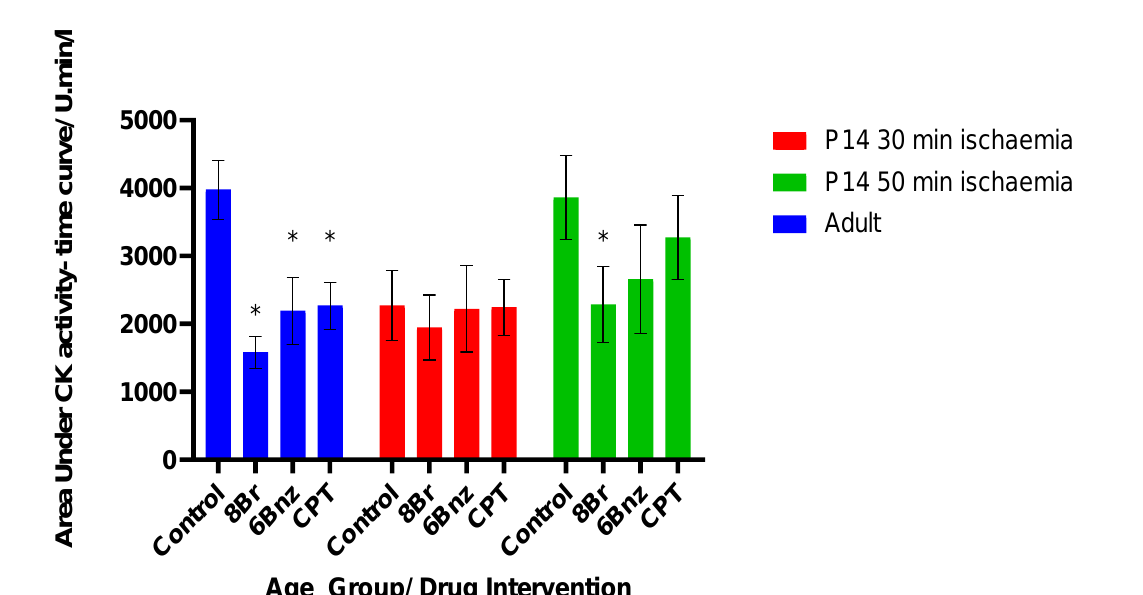
Figure 3. Total activity for CK in each age and treatment group for the cAMP analogue experiments. Total activity taken as estimated area under activity–time curves summed by trapezoidal addition of mean values for each time point. Bars represent mean area under curve of activity/time curves ± SE; * = p < 0.05 vs. same age group control. Significance tested by Student’s t -test. n = 6 per group. Hearts from 14-day-old rats (P14) were exposed to 30 or 50 min of global ischaemia (Figures 2B and 2C, respectively). The immature hearts exposed to 30 min of ischaemia did the time points studied. The peak activity level in the control was reduced to 58.6% of that seen in the adult control group, and arrived in a later fraction. Similarly, the area under the activity time curve in the P14 30 min ischaemia group was 57.1% of that in the adult group, representing a lower overall degree of injury and reduced CK activity (Figure